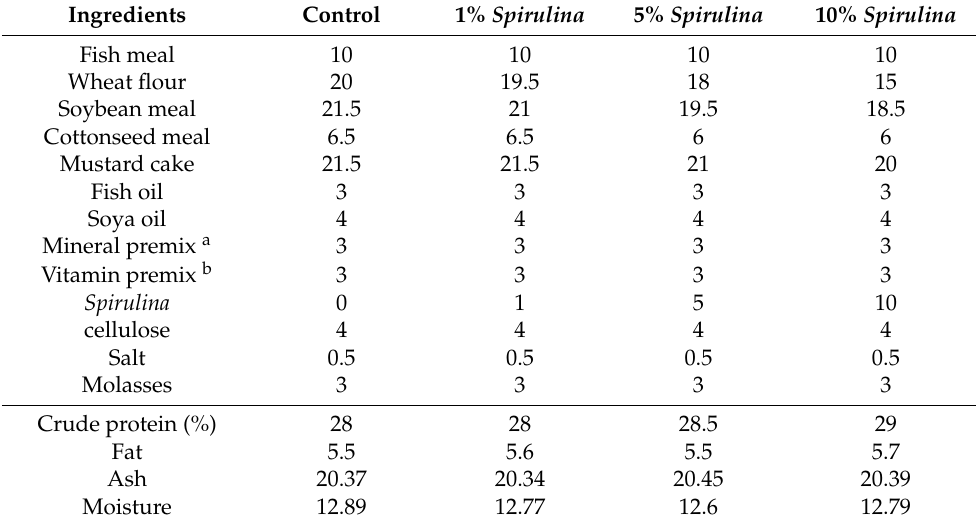
Table 1. Composition of basal and experimental diet